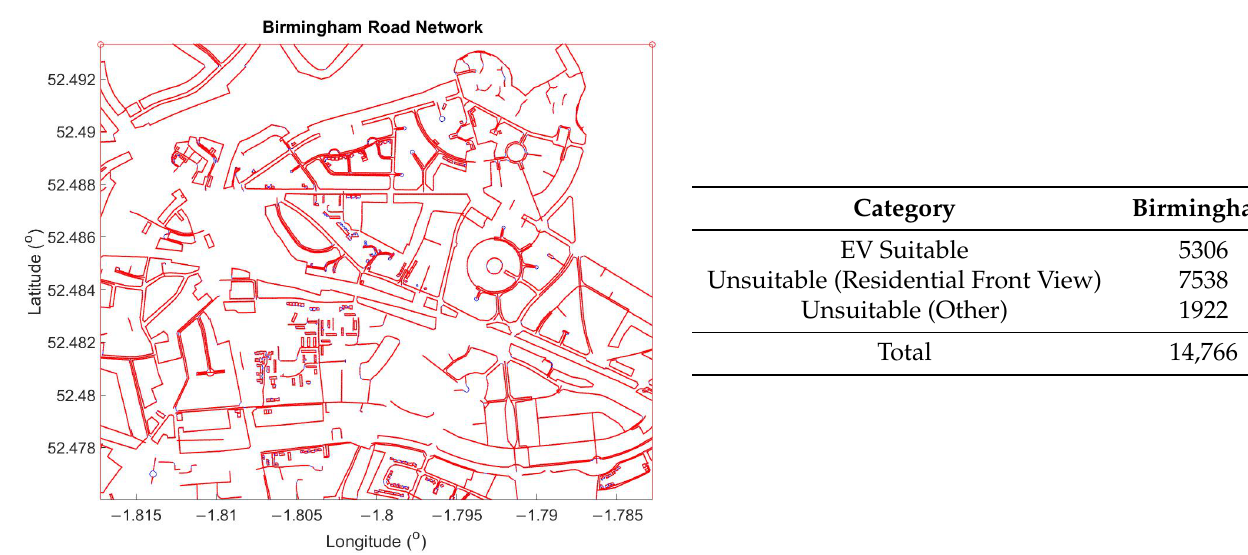
Figure 9. The locations of all downloaded images from the Birmingham test area ( Left ) and a breakdown of the image categories ( Right ).